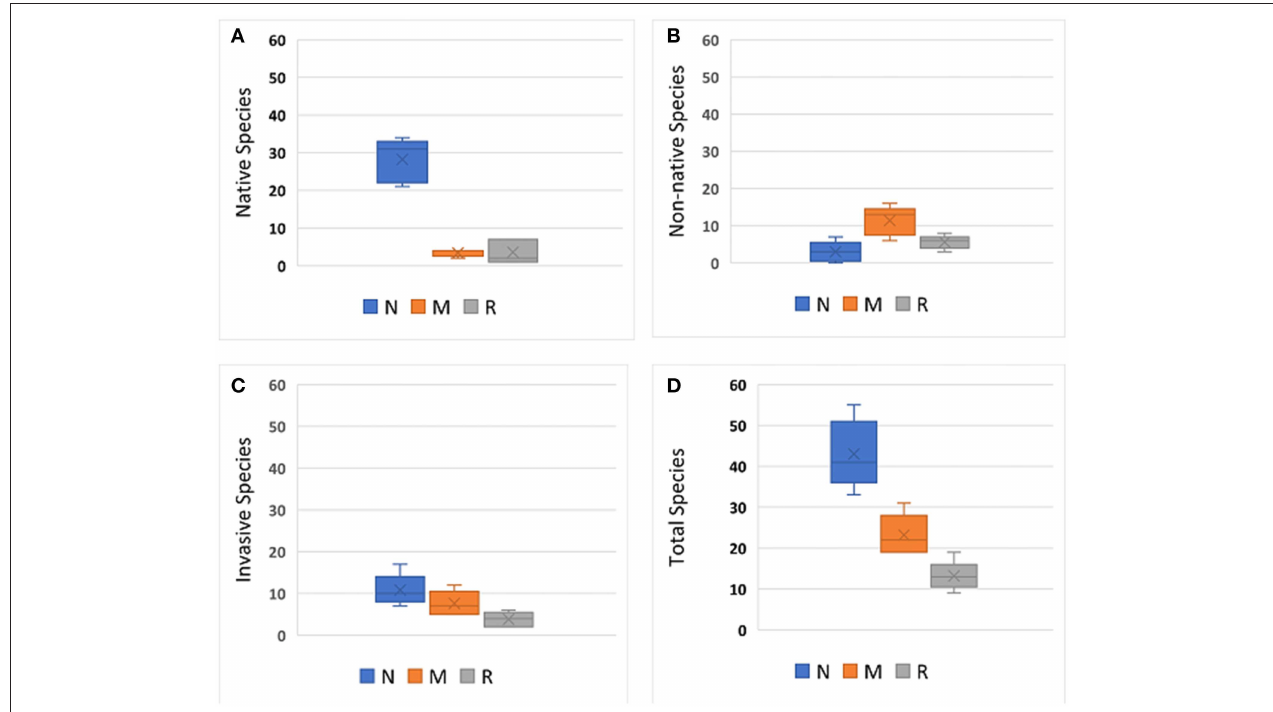
FIGURE 4 | Average number of plant species that were: (A) native, (B) non-native, (C) invasive, and (D) total for each park type. N, natural-passive use; M, multi-use; R, recreational-active use. Error bars represent ± 1 standard